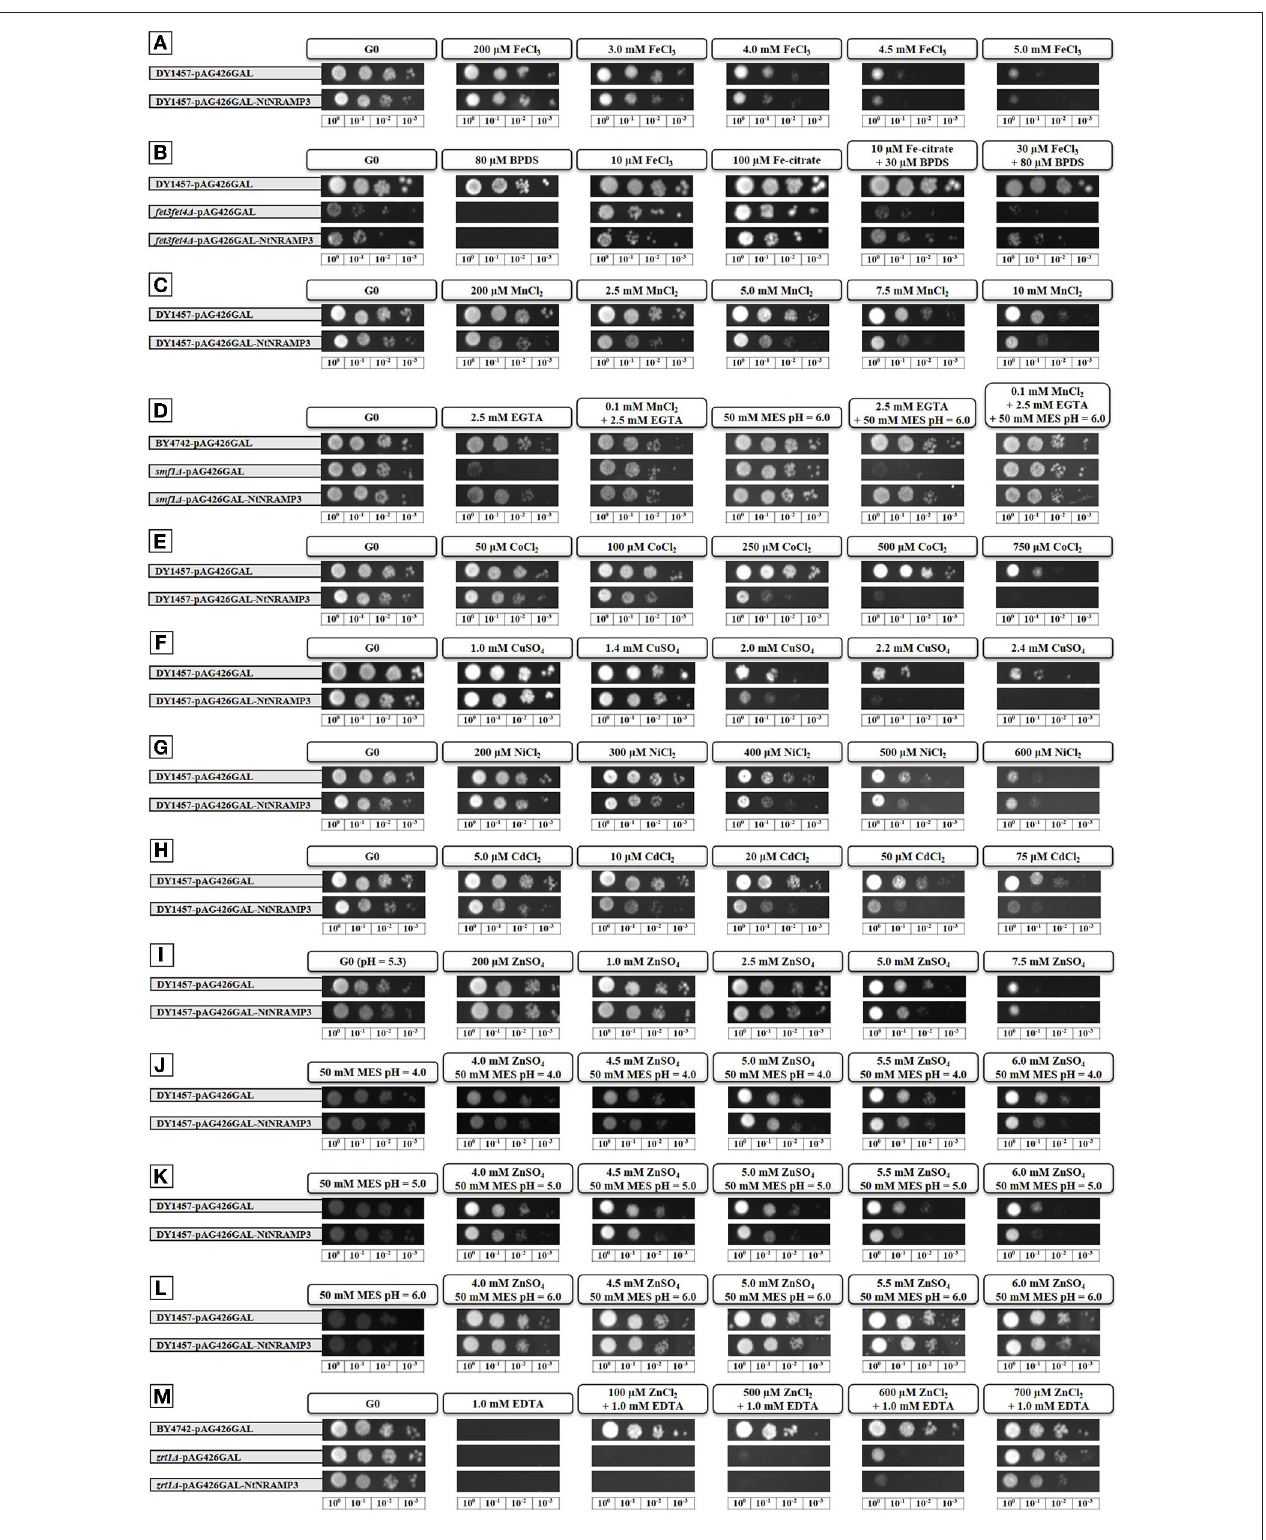
FIGURE 4 | NtNRAMP3 expression in selected yeast strains. Saccharomyces cerevisiae strains (i) wild-type (WT; DY1457 or BY4742) and (ii) deletion mutants 1 fet3fet4 (defective in Fe transport into the cell), 1 smf1 (defective in Mn transport into the cell) or 1 zrt1 (defective in Zn transport into the cell) were transformed with the empty vector pAG426GAL or with the construct pAG426GAL::NtNRAMP3 . The transformed cells were adjusted to OD 600 = 0.2, then a series of dilutions (1, 0.1,